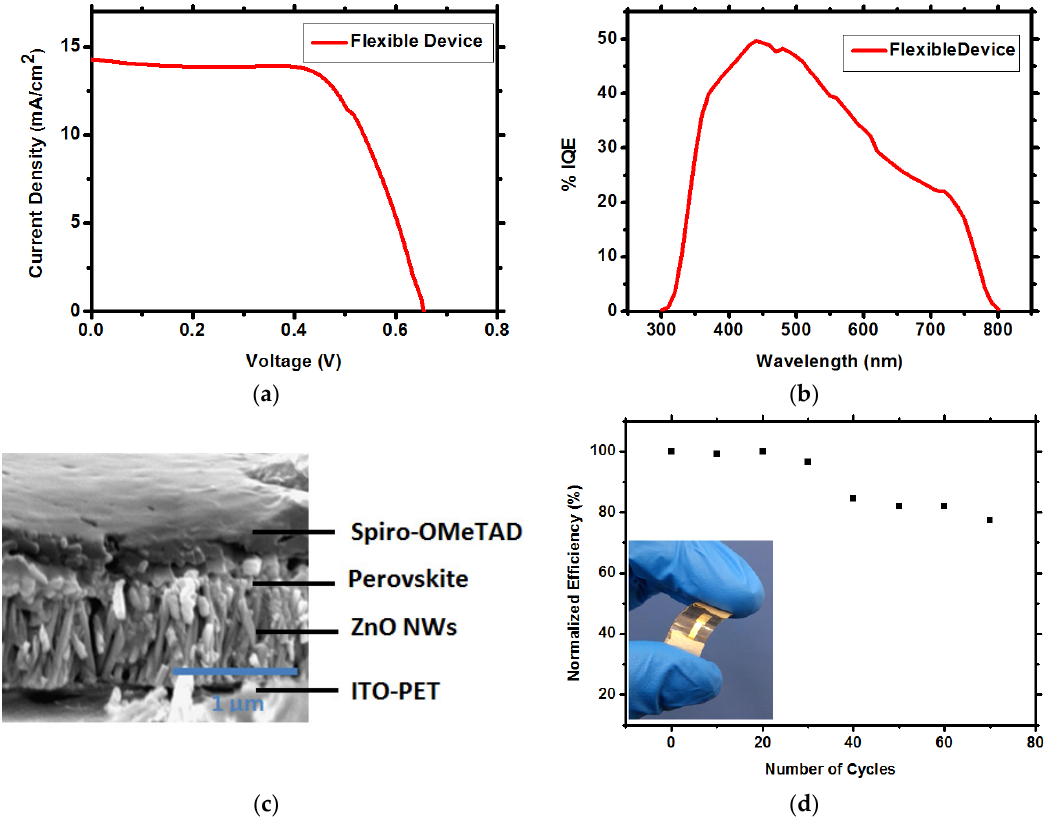
Figure 5. ( a ) IV curves of the ZnO NWs CH 3 NH 3 PbI 3 perovskite solar cell on flexible substrate; ( b ) IQE spectra of the corresponding flexible solar cell; ( c ) SEM cross section of the flexible ZnO NWs CH 3 NH 3 PbI 3 perovskite solar cell; ( d ) Stability of the flexible solar cell under bending. The bending radius is 1.2 cm. Inset: image showing typical, flexible ZnO NWs CH 3 NH 3 PbI 3 perovskite solar cell.